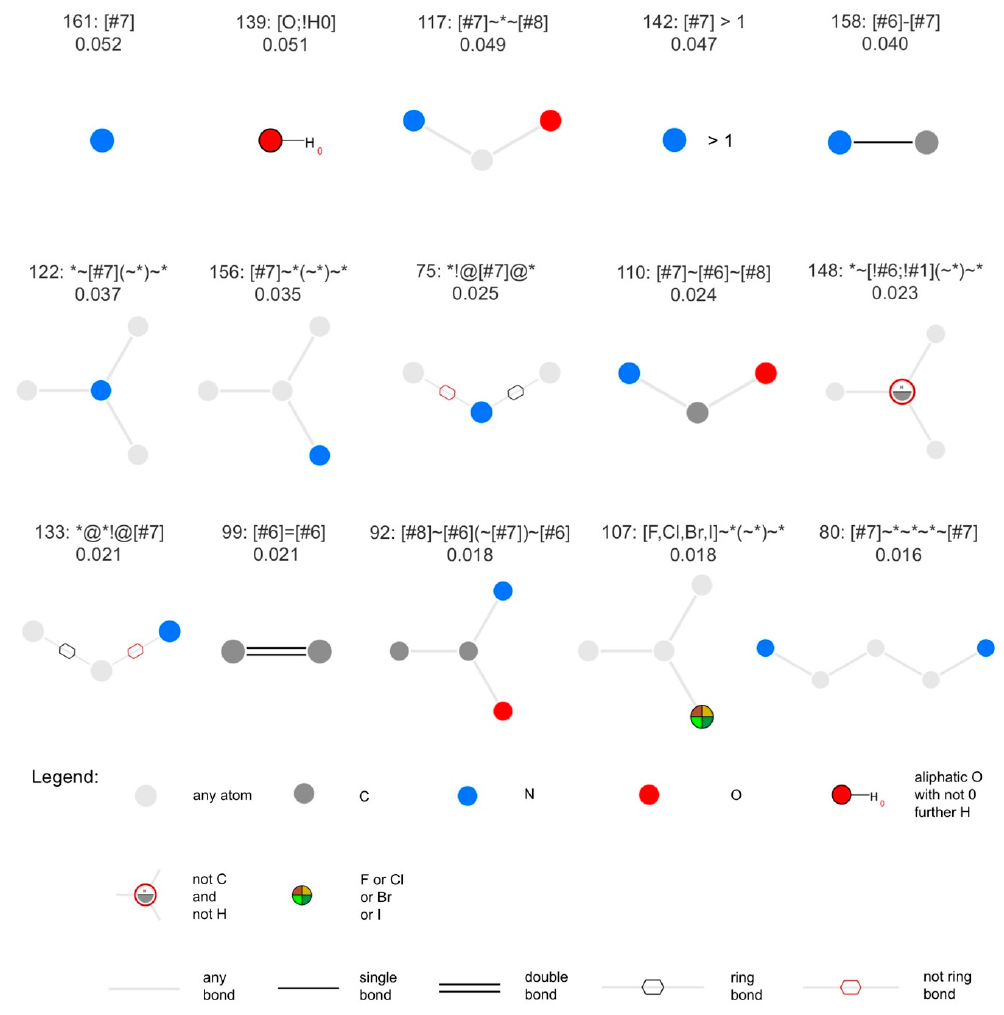
Figure 5. The 15 most relevant MACCS keys, sorted by decreasing feature importance. Above each diagram, the first line reports the index of the respective MACCS key and its SMARTS pattern. The